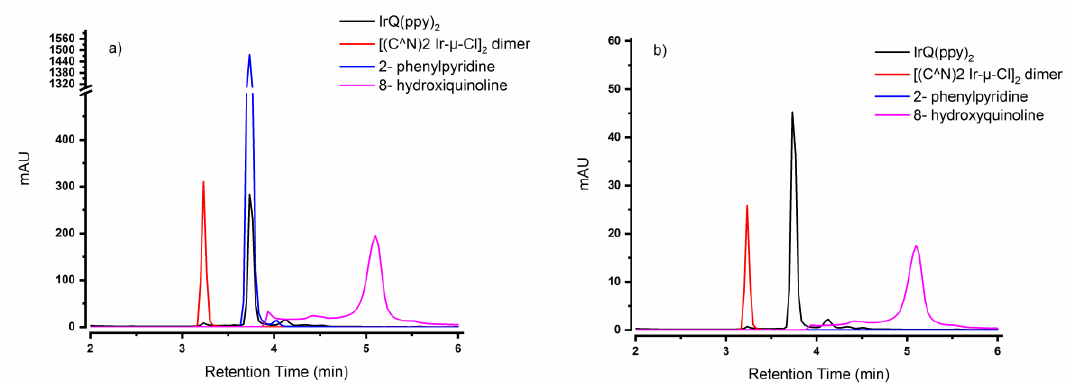
Figure 5. High-performance liquid chromatography (HPLC) analysis of IrQ(ppy) 2 , dimer and ligands at ( a ) 261 and ( b ) 403 nm.